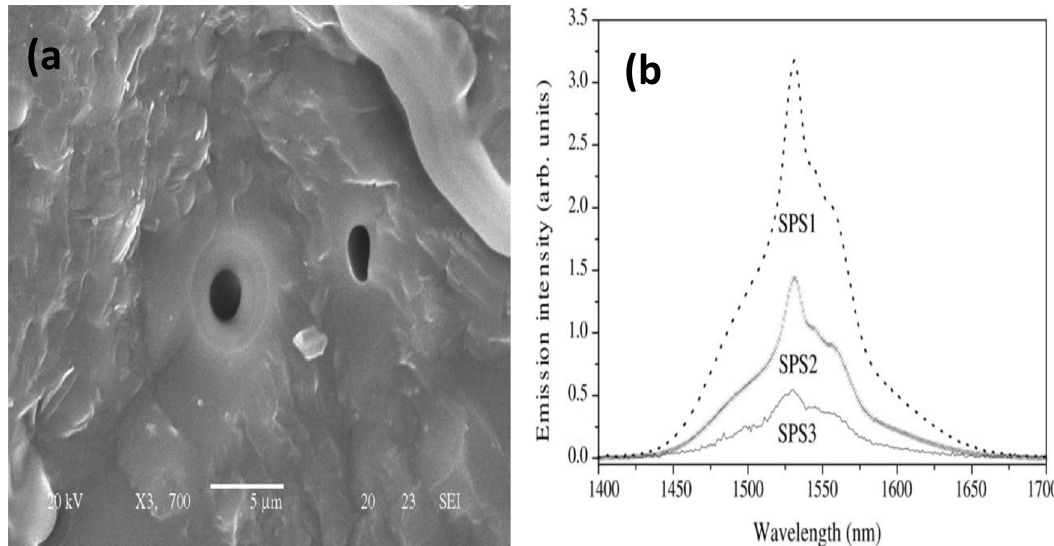
Figure 3. ( a ) SEM micrograph of SPS3, showing the residual porosity and ( b ) IR emission spectra of LAS-Er-Zr samples. Reprinted with permission from the Journal of the European Ceramic Society [51]. SPS, spark plasma